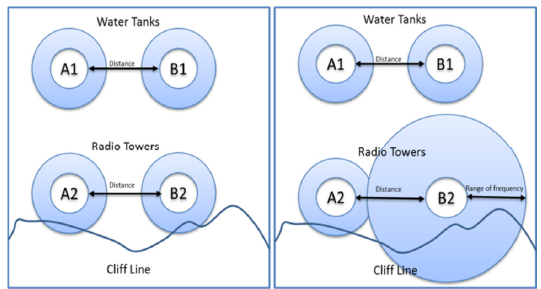
Figure 1. An example of difference between influence areas (Kettani and Moulin, 1999) and impact area (Brennan and Martin,